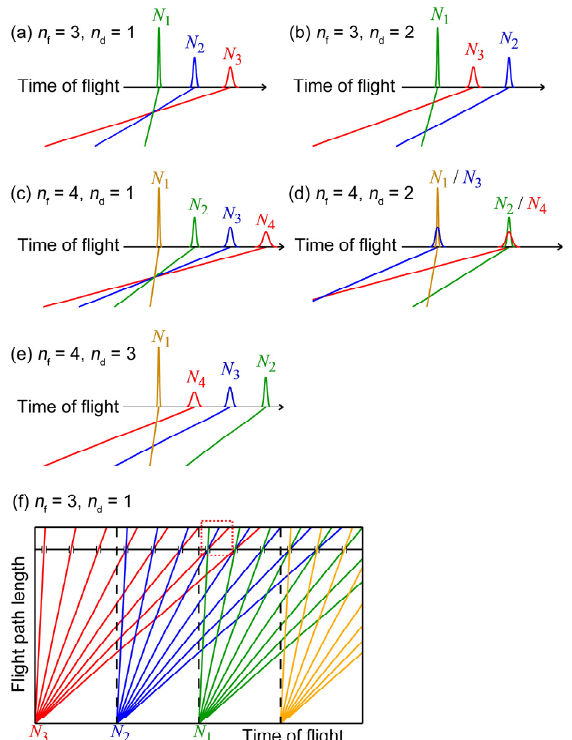
Fig. 4. Some of sequences of E i as examples to explain definition of N n and n d . Possible sequences of E i s are described in the cases of n f = 3 ((a) and (b)) and 4 ((c) ~ (e)). Corresponding n d s are shown together. When n d and n f are not relatively prime numbers, neutrons from different source pulses arrive at same time at the detector position as can be seen in (d). (f) The full TOF diagram of the case (a) ( n f = 3, n d = 1). E i s from the time < 0 are omitted in the figure. The panel (a) corresponds to the area surrounded by the red square in